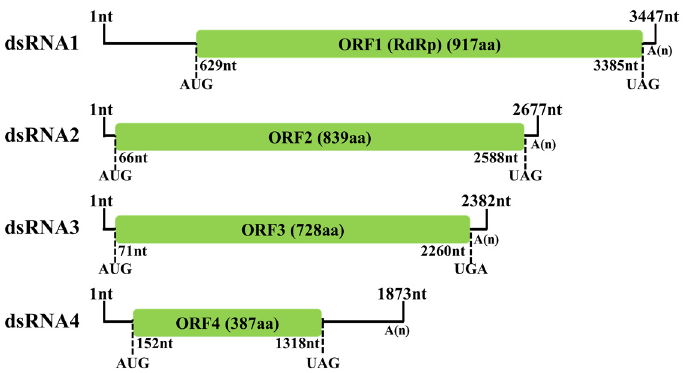
Figure 2. Schematic representation of the FoAV1 genome. The open reading frames (ORFs) and coding loci are indicated by a green box and single dotted lines, respectively.